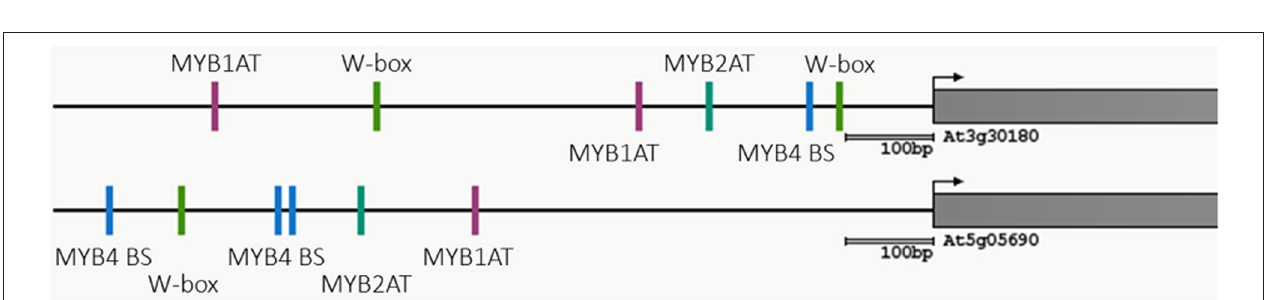
FIGURE 3 | Treatment with flg22 does not affect phosphorylation of BZR1. Accumulation of BZR1-YFP in its phosphorylated (pBZR1-YFP) and de-phosphorylated (BZR1-YFP) forms upon treatment with flg22 (F), brassinolide (BL), flg22 and brassinolide (F + BL) or mock solution. Ten-day-old transgenic Arabidopsis seedlings expressing BZR1-YFP were submerged in a 100 nM flg22, 1 m M brassinolide, 100 nM flg22 + 1 m M brassinolide or mock solution for 1 h. Total proteins were separated in a 10% acrylamide gel and transferred to a PVDF membrane. The membrane was blotted with anti-GFP antibody. CBB: Coomassie brilliant blue. This experiment was repeated four times with similar results.